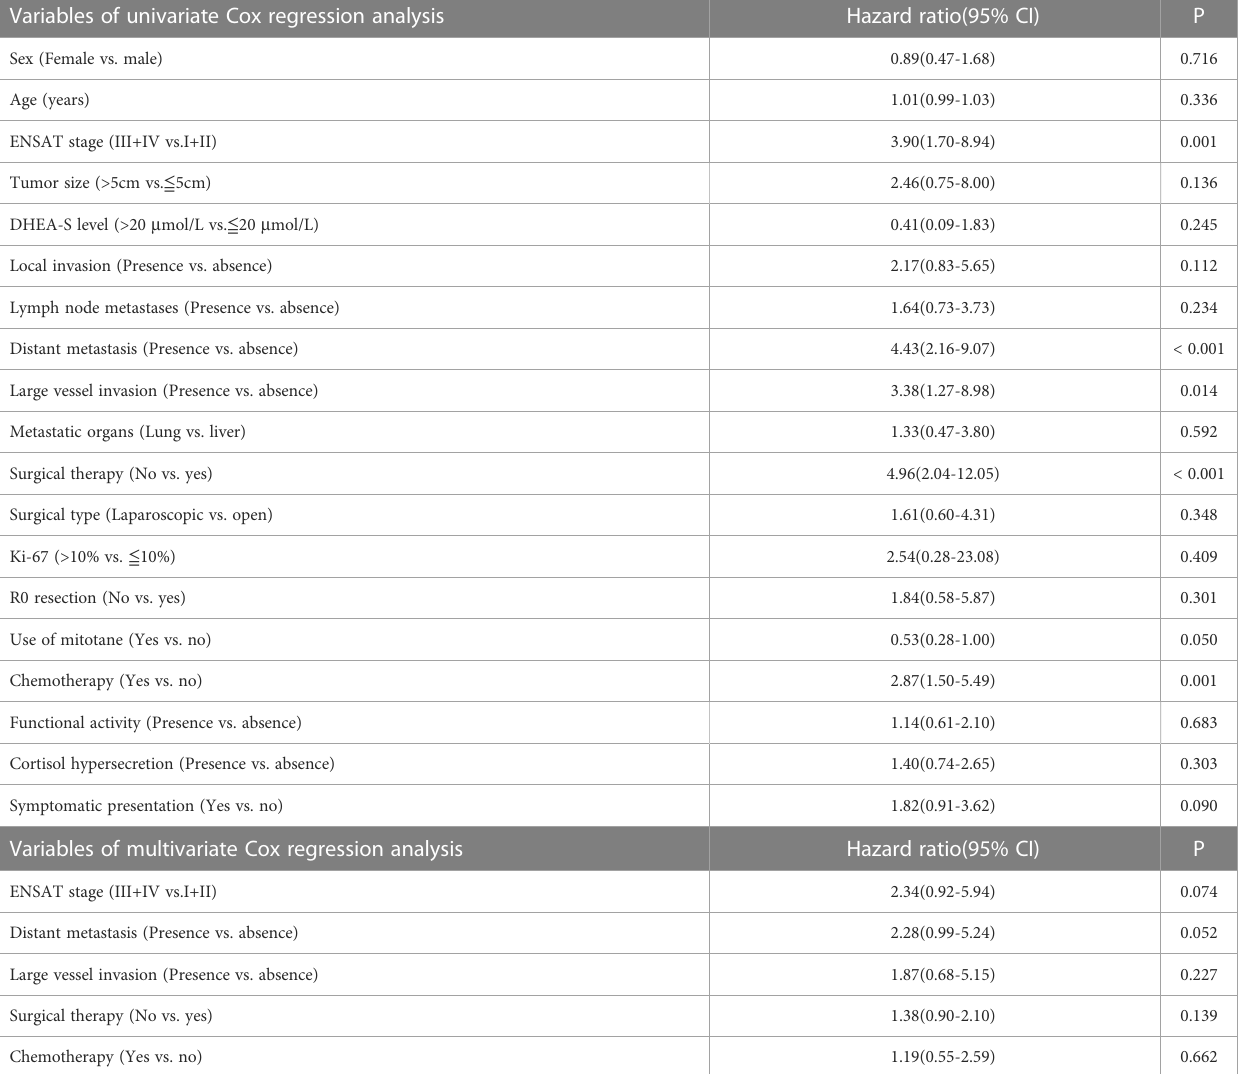
TABLE 4 Univariate and Multivariate Cox regression analysis on progression-free survival. Variables of univariate Cox regression